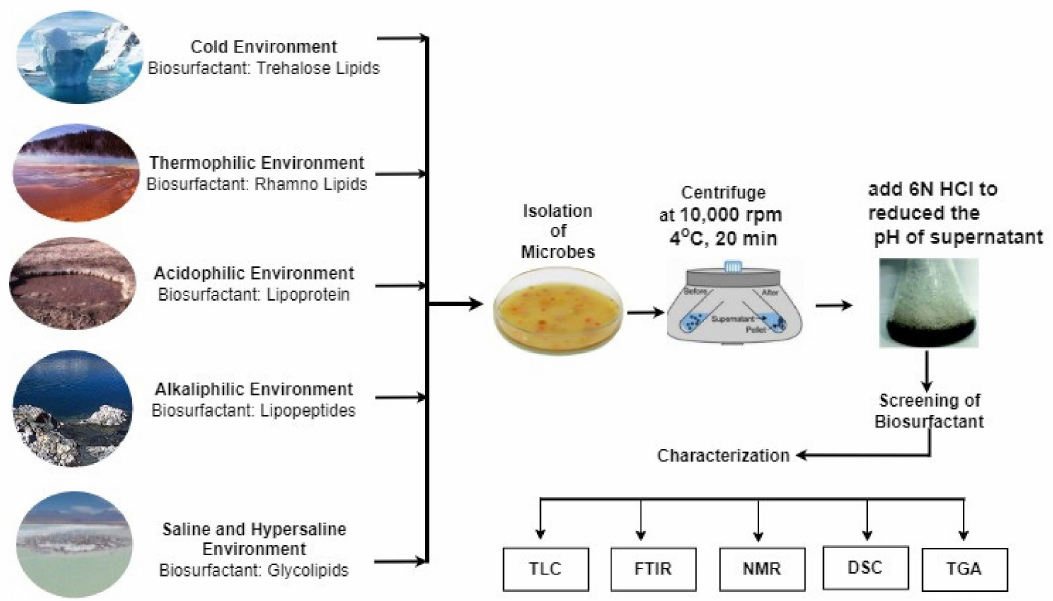
Figure 6. Isolation, screening and characterization of biosurfactants.